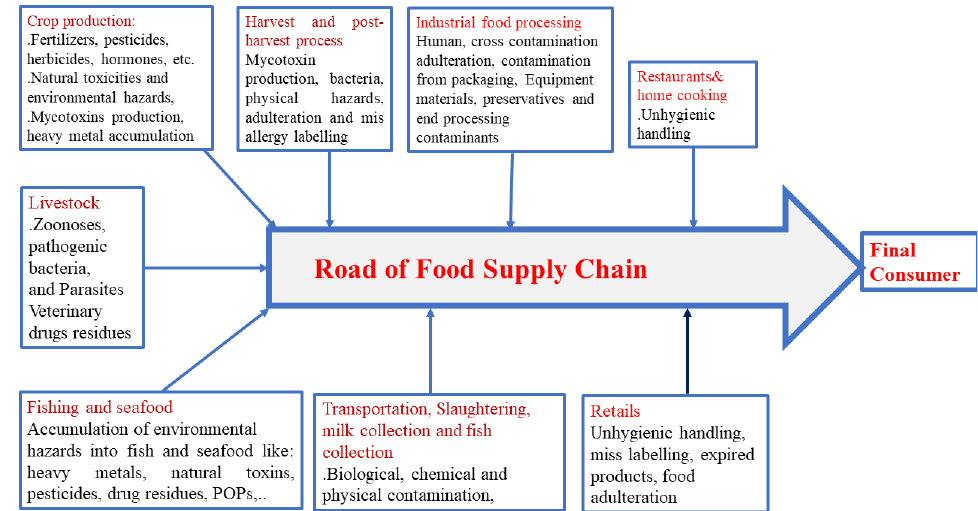
Figure 1. Prominent routes of food hazards and food contaminant exposure.